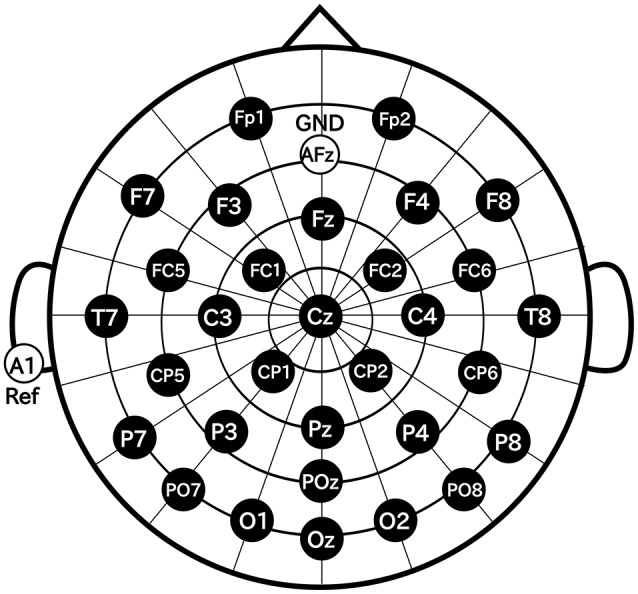
Electrode positions.